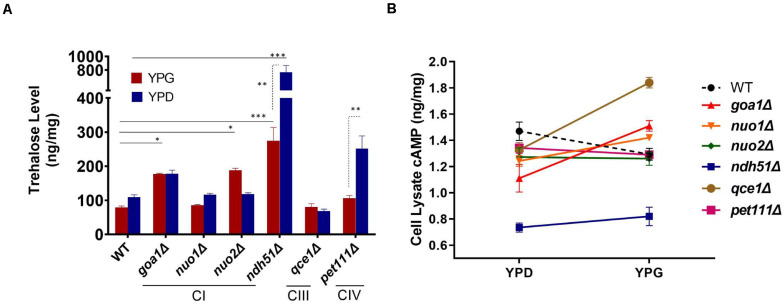
Metabolite disorders associated with the severity of cAMP reduction under mitochondrial stress. Growth conditions for YPG in ETC mutants initiated with 10-h YPD (2% glucose) culture due to their inability to utilize non-fermentable carbon sources. After washing twice with PBS, the cells from mutants and WT were transferred to YP-2% glycerol medium for 2 h before cell lysate preparation. (A) Trehalose content in ndh51Δ increases sevenfold (YPD) and threefold (YPG) over WT, which correlates with the greatest cAMP reduction in this mutant. Significant increases in trehalose are also shown in the CI regulator goa1Δ and nuo2Δ (under YPG) and in pet111Δ (under YPD). (B) Non-fermentable glycerol (YPG) growth represses cAMP levels and slightly decreases trehalose content in WT when compared with YPD. A contrary impact on the cAMP levels is seen in most ETC mutants during YPG growth. The changes in cAMP level between YPD and YPG in each mutant do not correlate with trehalose production in panel (A). *p < 0.05, **p < 0.01, ***p < 0.001.